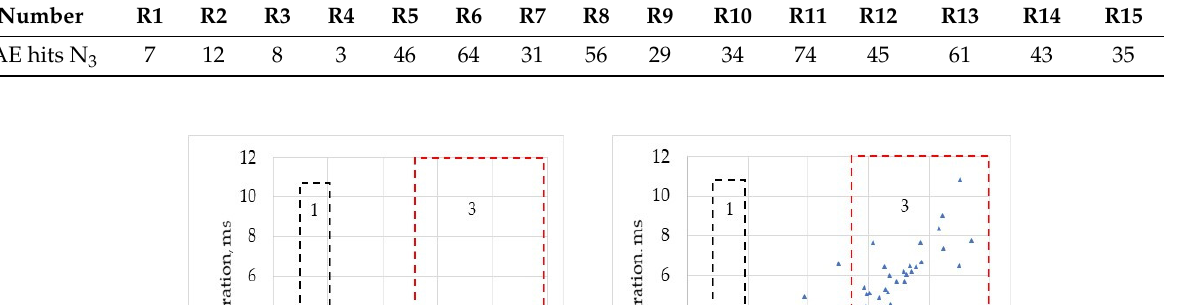
Table 4. The values of the criterion parameter N 3 .